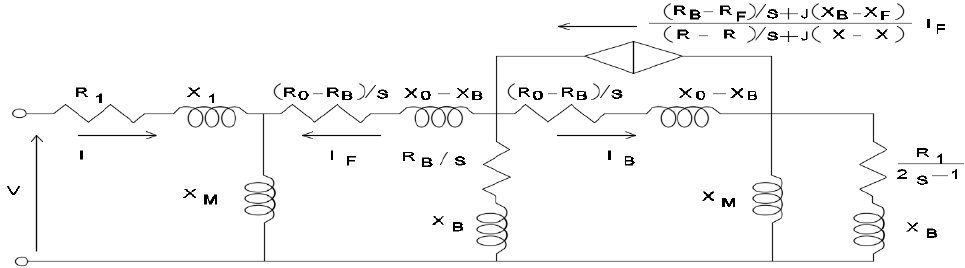
Figure 9. Equivalent motor circuit in a stable state with rotor asymmetries, as shown in [12]. Reproduced with permission from IEEE,